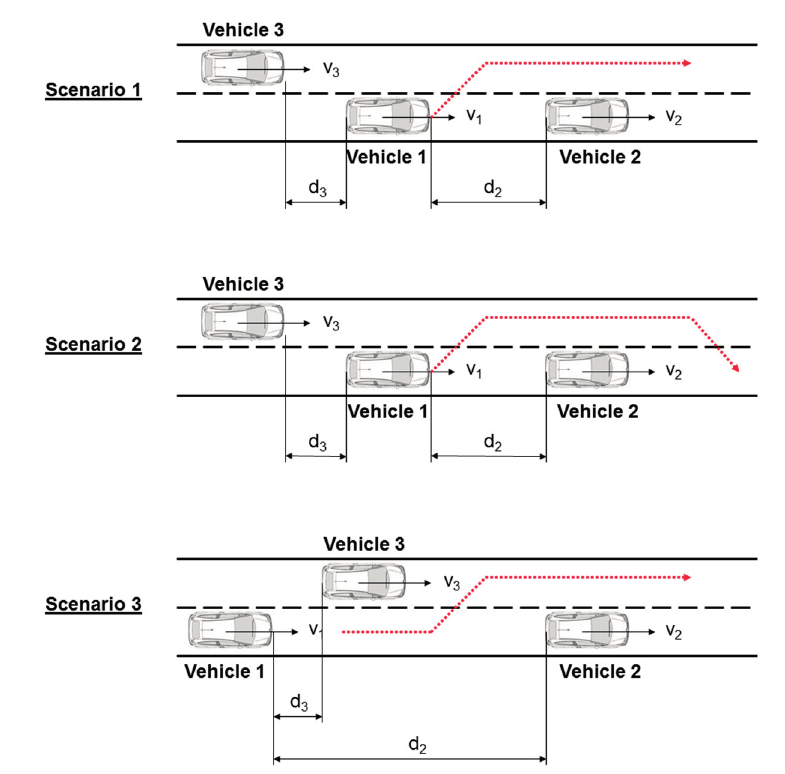
Figure 5. Additional study cases included, using a more complete understanding of the